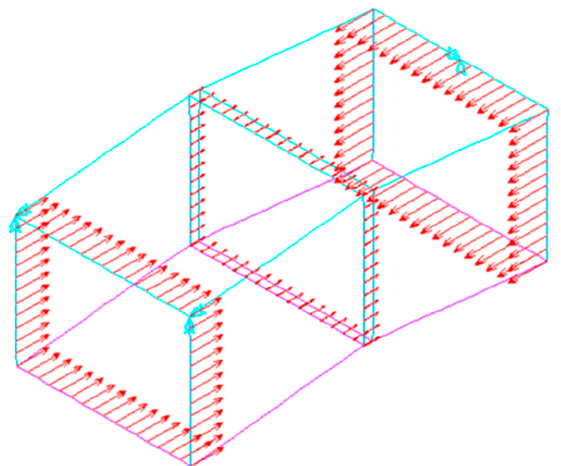
Figure 6. Longitudinal Hydrostatic Buckling mode of a two cages system applied to a distributed current load, in the Drift State. The distributed forces are represented in red and the constraints in light blue arrows.